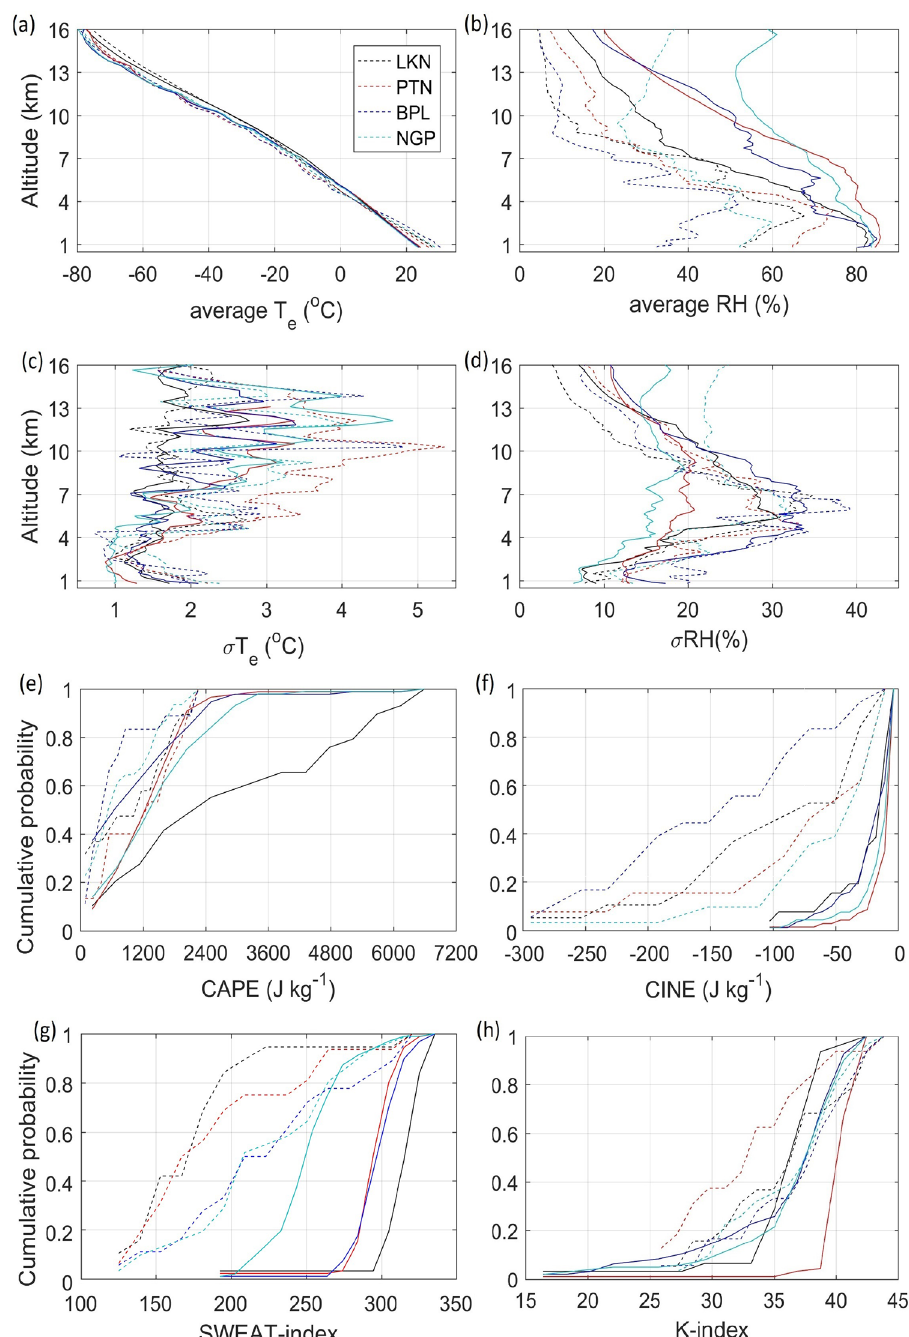
Figure 3. The mean ( a , b ) and 1-standard deviation ( σ ) ( c , d ) profiles of environmental temperature ( T e ) and relative humidity (RH). The data are based on 12 UTC (1730 IST) sounding. Average environmental conditions over each radar location. The parameters shown are cumulative probability distributions of ( e ) convective available potential energy (CAPE), ( f ) convective inhibition energy (CINE), ( g ) severe weather threat (SWEAT) index, and ( h ) K-index (KI). The data for the pre-monsoon and monsoon seasons are shown in dashed and solid curves,